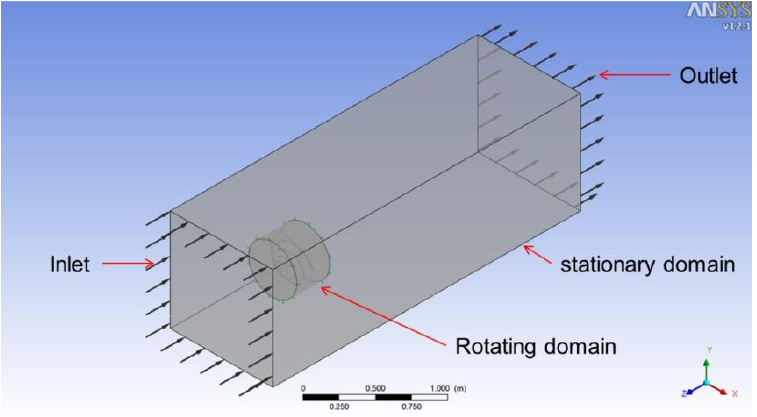
Figure 4. Boundary condition setup for